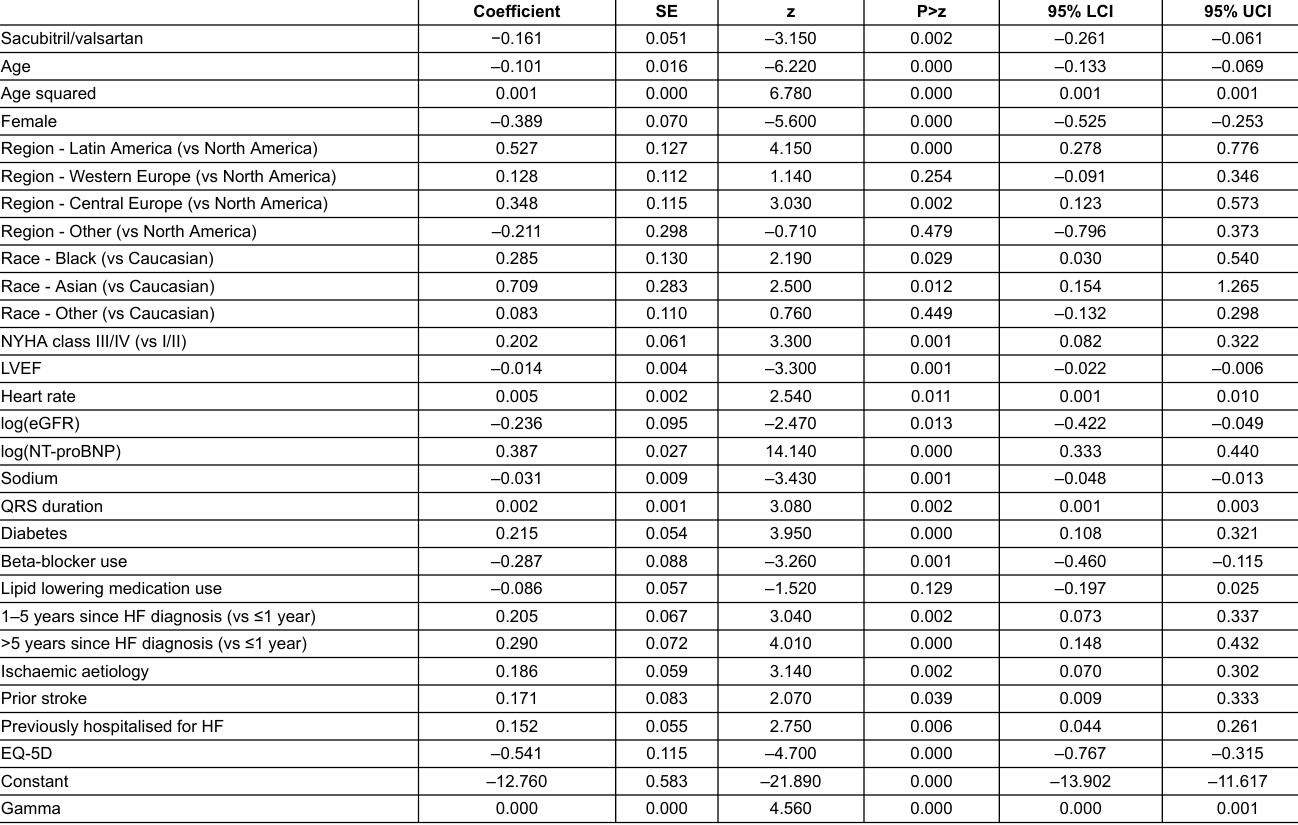
Table S2: Gompertz regression model for all-mortality (n =